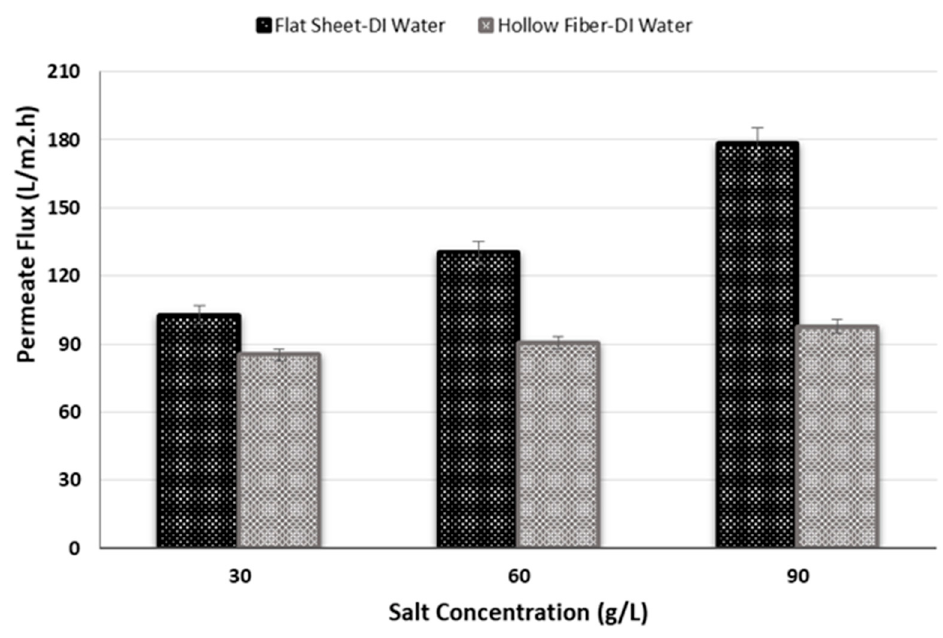
Figure 6. Influence of salt concentration on permeate flux for two different membrane modules.